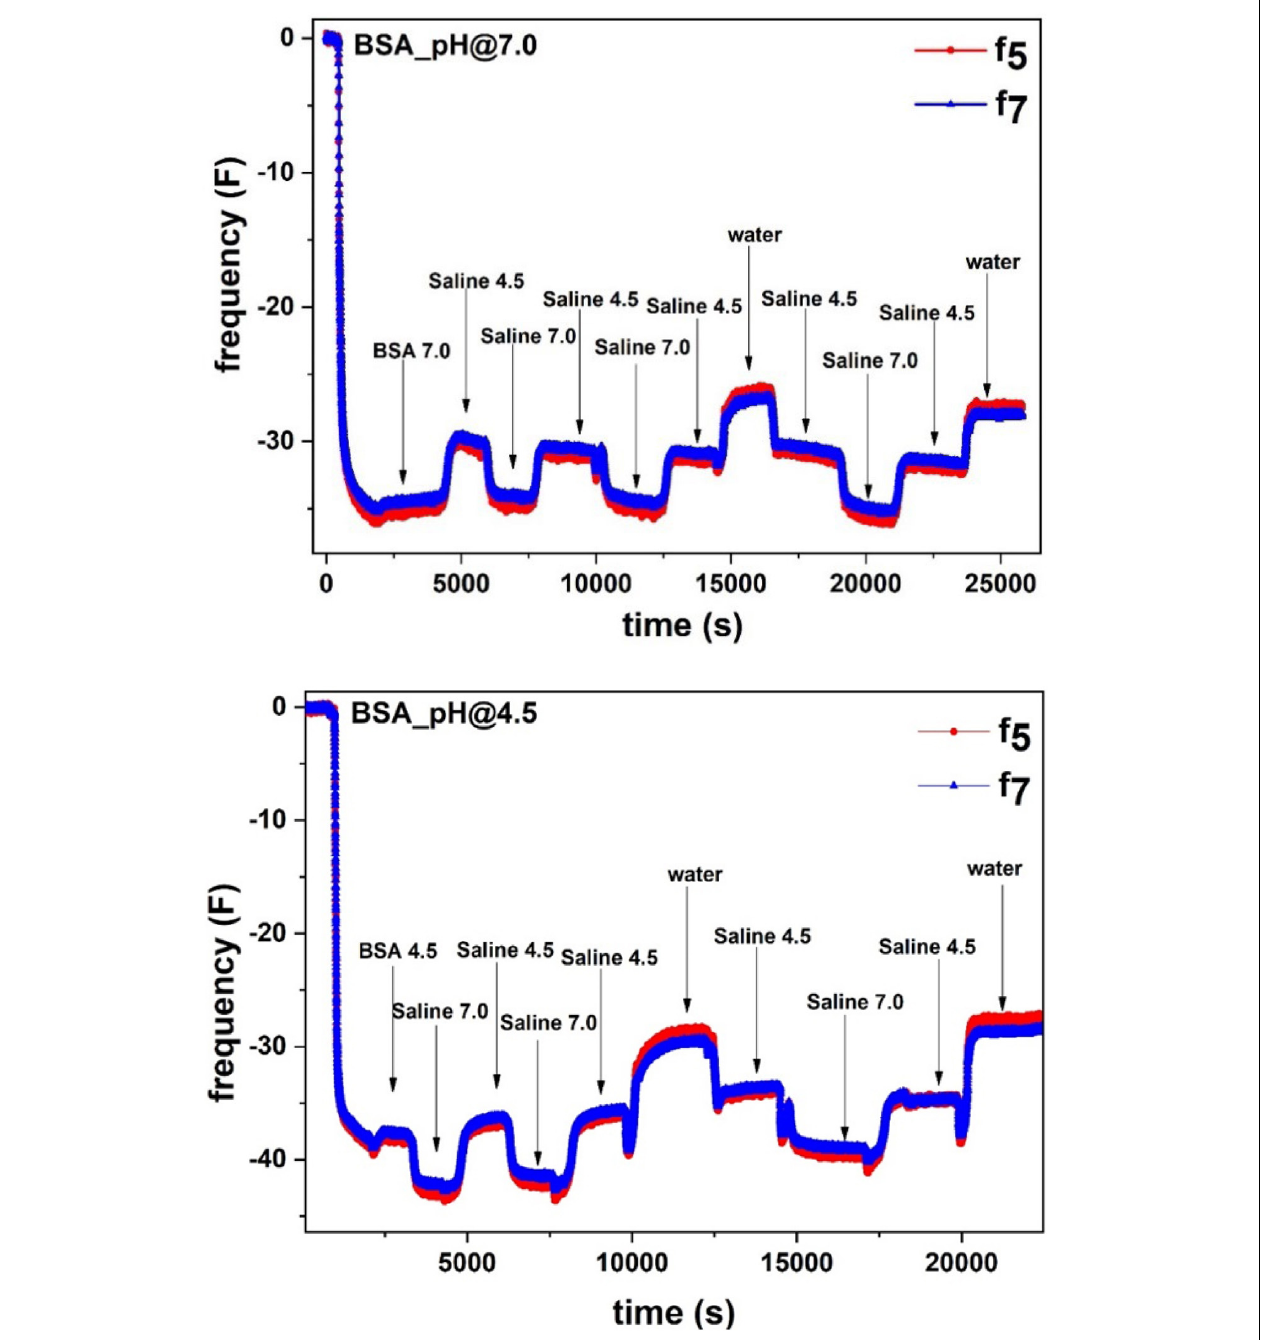
FIGURE 1 | (Top) Adsorption of BSA (1 mg/mL) in 0.9% NaCl saline solution at pH 7.0 on the liquid-gold interface. After BSA adsorption saturation, the sensor surface was rinsed with the saline solution at pH 7.0, followed by rinsing cycles of saline at pH 4.5, pH 7.0 and water. (Bottom) Adsorption of BSA (1 mg/mL) in 0.9% NaCl saline solution at pH 4.5 on the liquid-gold interface. After BSA adsorption saturation, the sensor surface was rinsed with the saline solution at pH 4.5, followed by rinsing cycles of saline at pH 7.0, pH 4.5 and water.